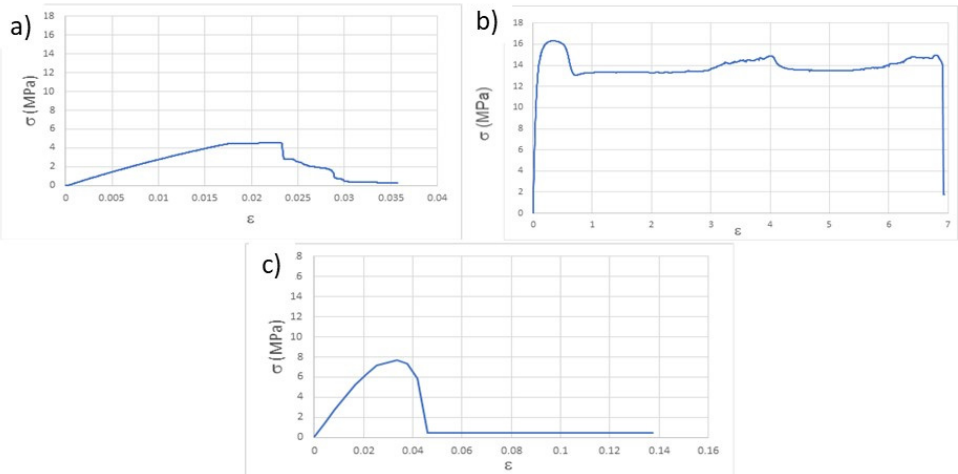
Figure 2. Representative stress-strain curves resulting from the tensile tests of the as-printed specimens: ( a ) T, ( b ) P h , ( c ) P v . Table 3. Mean and standard deviation values of the mechanical properties calculated from the tensile tests of the as-printed PCL specimens.